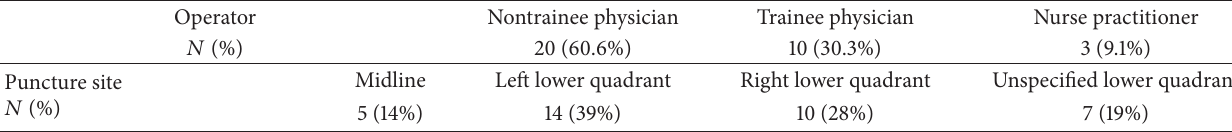
Table 2: Summary of operator type and puncture site.